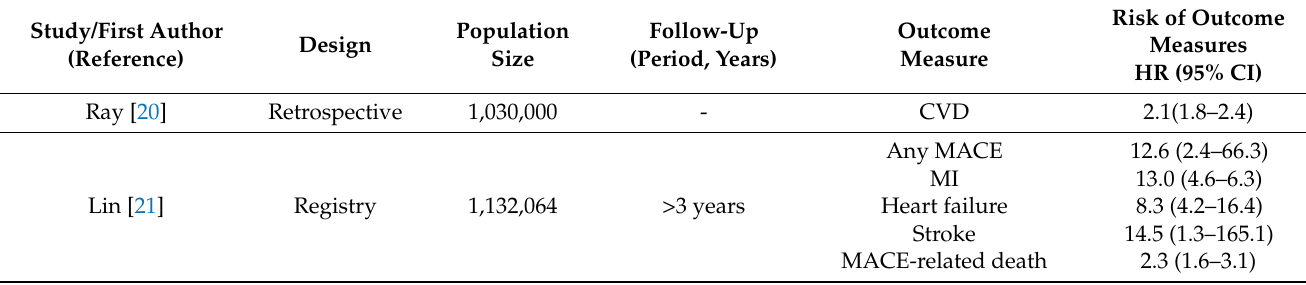
Table 2. Selected published studies of preeclampsia and future risk of cardiovascular